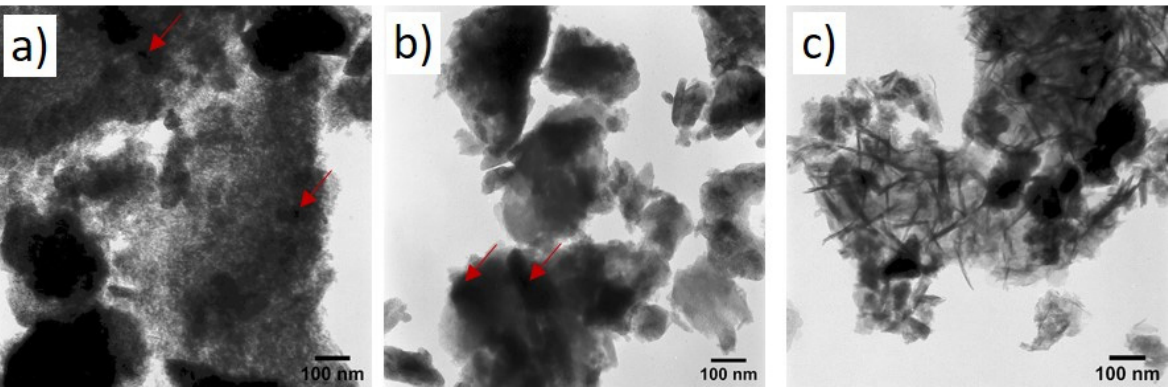
Figure 5. TEM images of Al 2 O 3 /SrCO 3 sol–gel with Pt after annealing at 500 °C with molar ratios of: ( a ) Sr0.1 Pt, ( b ) Sr0.25 Pt, and ( c ) Sr0.5 Pt. Table 1. Textural properties of Sr